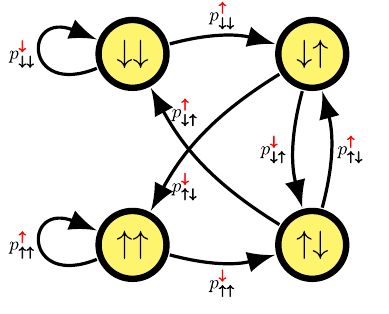
FIG. 8. ϵ -Machine that generates the spin configurations occurring in the one-dimensional ferromagnetic next-nearest- neighbor Ising spin chain with the Hamiltonian in Eq. (5).